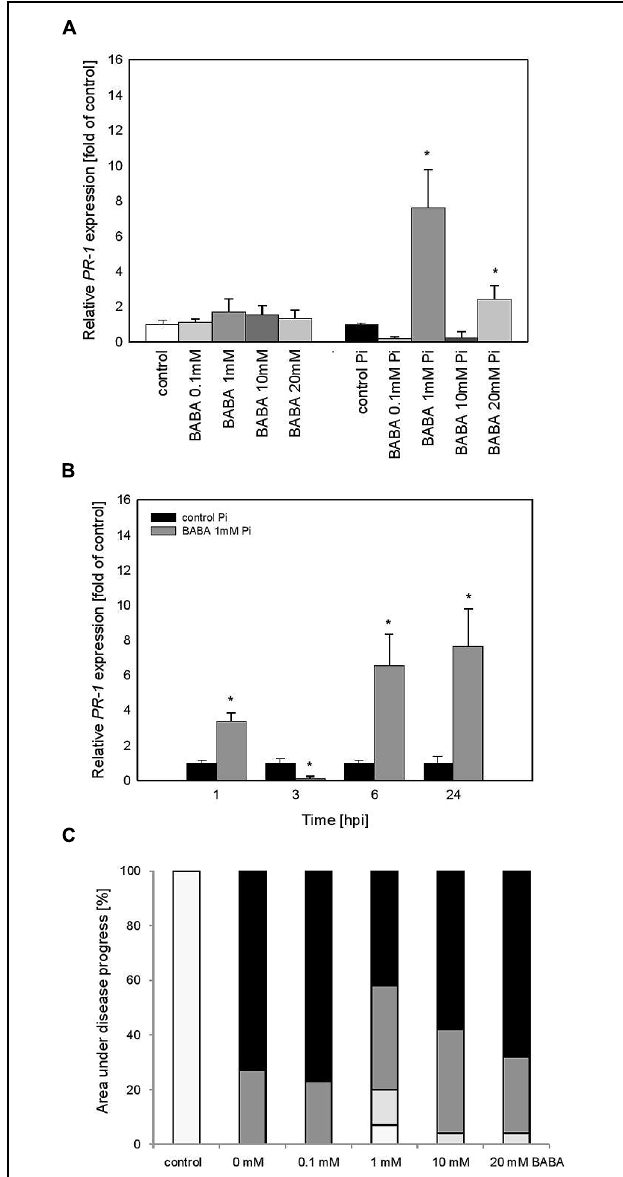
FIGURE 5 | PR-1 gene transcript accumulation in progeny lines of immunized potato plants (B A ) – offspring received from the BABA-treated parental line with use of plants derived from lateral buds propagated from in vitro seedlings. (A) After induction of B 0 -originated plants with BABA (left bars) and 24 h after inoculation of previously immunized plants (right bars), (B) a time-dependent analysis of PR-1 gene expression in P. infestans -inoculated plants obtained from the parent sensitized with 1 mM BABA (in B 0 stage). (C) disease development index at 7 dpi in the BABA-treated parental line with use of plants derived from lateral buds propagated from in vitro seedlings, ∗ significantly different from control leaves, P < 0.05. Values represent means of data ± SD of at least three independent experiments, each with at least three biological replicates.